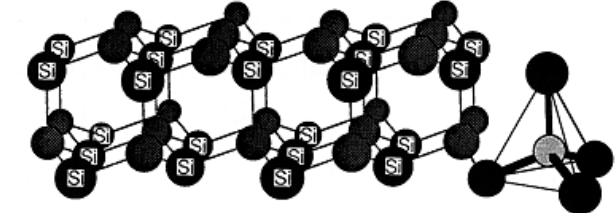
Figure 9. Schematic showing different terminations of the (000¯1)/(¯1¯1¯1) and (0001)/(111) faces of SiC. Stacking in this case is for cubic SiC. A representative Csi4 tetrahedron is also shown. Reprinted with permission from Reference [27]. Copyright 1996 The American Ceramic Society/Wiley.